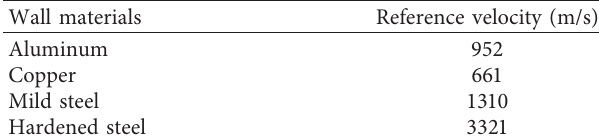
Figure 1: Finnie erosion model. Table 1: Reference velocity